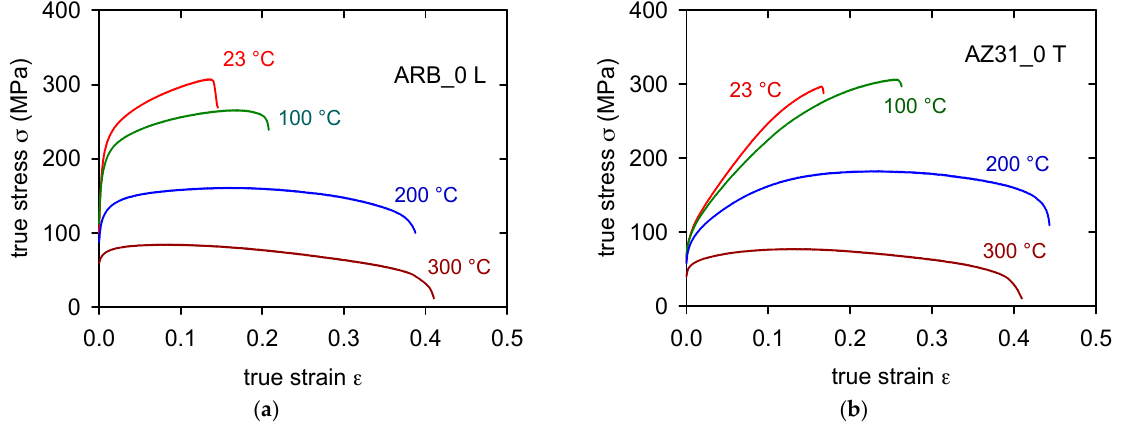
Figure 7. True stress-true strain curves obtained for four temperatures of ARB_0 samples for L-orientation ( a ) and T-orientation ( b ).